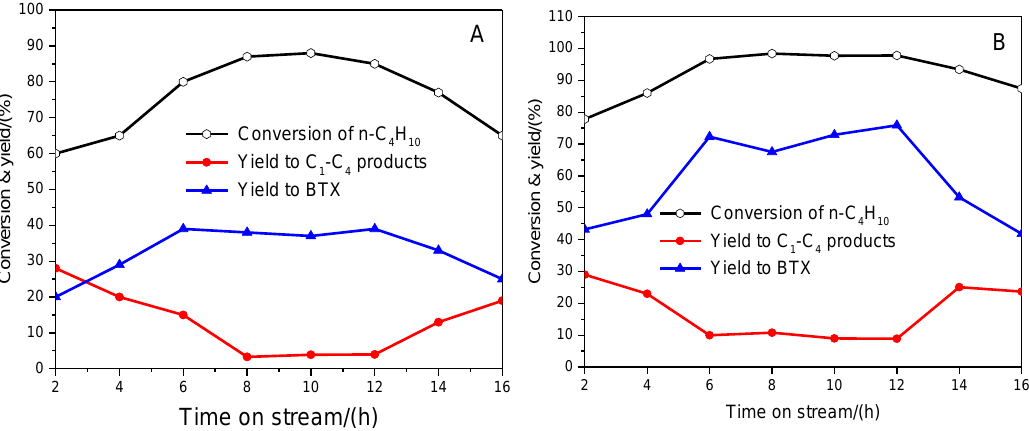
Figure 9. Stability (n-butane conversion, yields to benzene, toluene, and xylenes [BTX] and gas products) of Pt Mo IMP ( A ) and Pt Mo BM ( B ) catalyst with time-on-stream (TOS).